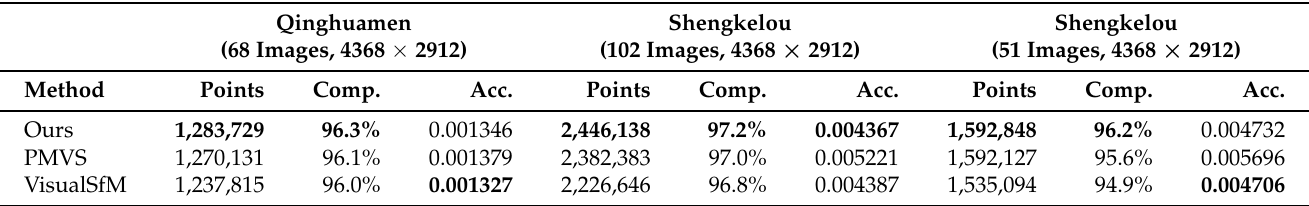
Table 3. Quantitative results of the three algorithms on different datasets when τ = 50%. Bold number indicates the best result for each metric.